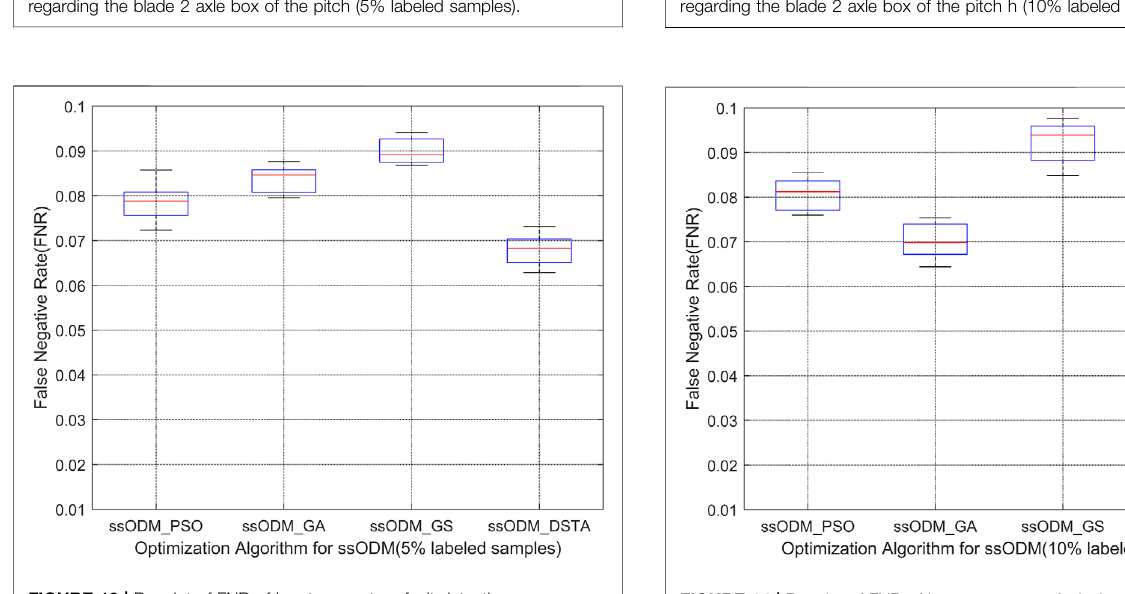
FIGURE 14 | Boxplot of FNR of low-temperature fault detection regarding the blade 2 axle box of the pitch h (10% labeled